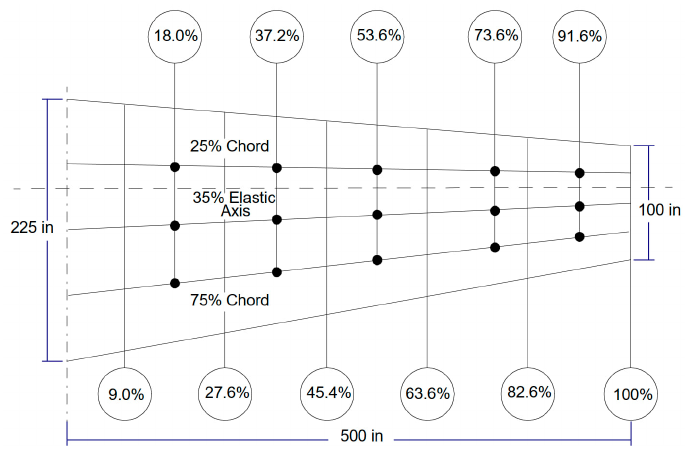
Figure 4. BAH wing planform and aerodynamic boxes (adopted from Rodden and Johnson [27]).